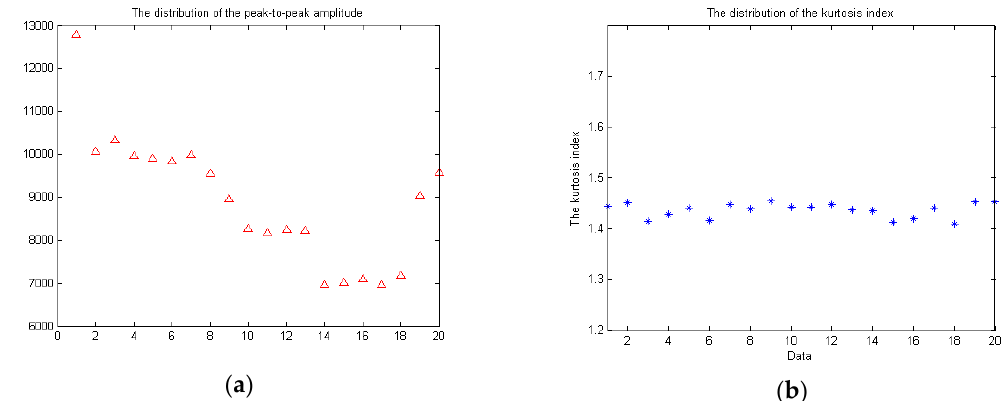
Figure 14. Distribution of the indexes: ( a ) peak-to-peak amplitude; ( b ) kurtosis index.